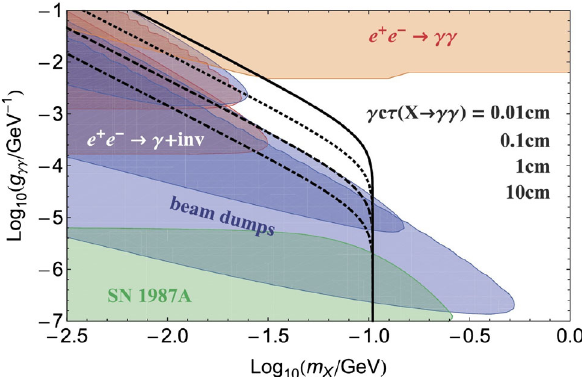
Fig. 2 Excluded parameter regions for a scalar X with mass m X and coupling g γγ to 2 γ s from collider, beam dumps, and supernova [34– 36] (from [33]). In black we show contours of the boosted decay length γ c τ → γγ , assuming X to be produced from an at-rest muon X of X decay μ + → e + X. The solid black line corresponds to γ c τ X = 0 . 01 cm, the dotted one to 0.1 cm, the dashed one to 1 cm and the dot-dashed line to 10 cm